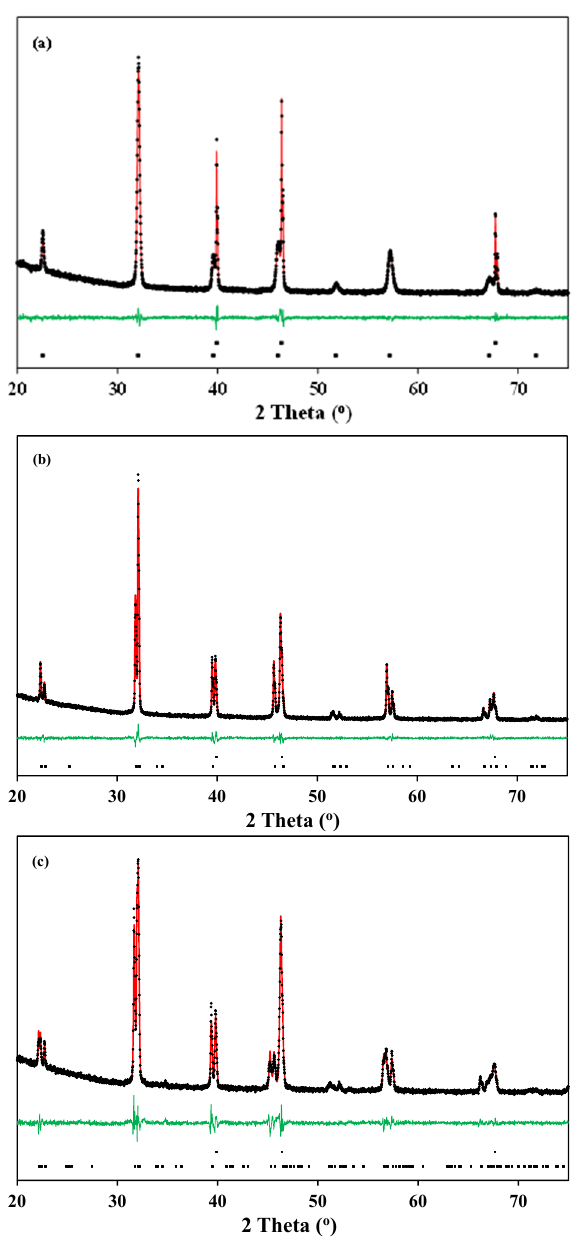
Figure 4. Typical Rietveld fit of the X ‐ ray diffraction patterns of: ( a ) cubic ( (cid:1842)(cid:1865)3 (cid:3364) (cid:1865) ) La 0.5 Ba 0.5 CoO 3 ‐δ at 600 °C in O 2 ; ( b ) tetragonal ( P4/mmm ) LaBaCo 2 O 5+ δ at 600 °C in O 2 ; and ( c ) orthorhombic ( Pmmm ) LaBaCo 2 O 5+ δ at 600 °C in N 2 . The Bragg reflections of Pt and either La 0.5 Ba 0.5 CoO 3 ‐δ or LaBaCo 2 O 5+ δ are included at the bottom of each figure. Table 1. Crystallographic data at 600 °C of cubic La 0.5 Ba 0.5 CoO 3 ‐δ and tetragonal LaBaCo 2 O 5+ δ in O 2 ; and orthorhombic LaBaCo 2 O 5+ δ in N 2 : lattice parameters, atomic positions, occupancies, thermal parameters (B eq ) and goodness of fit (R wp ).